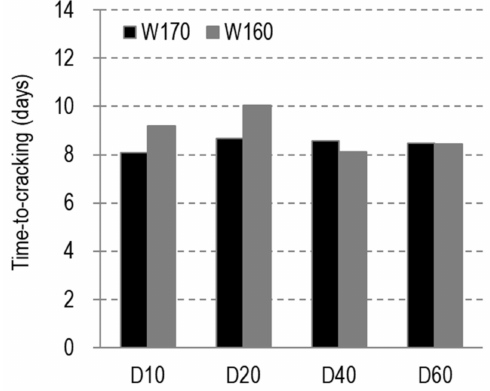
Figure 9. Net time to